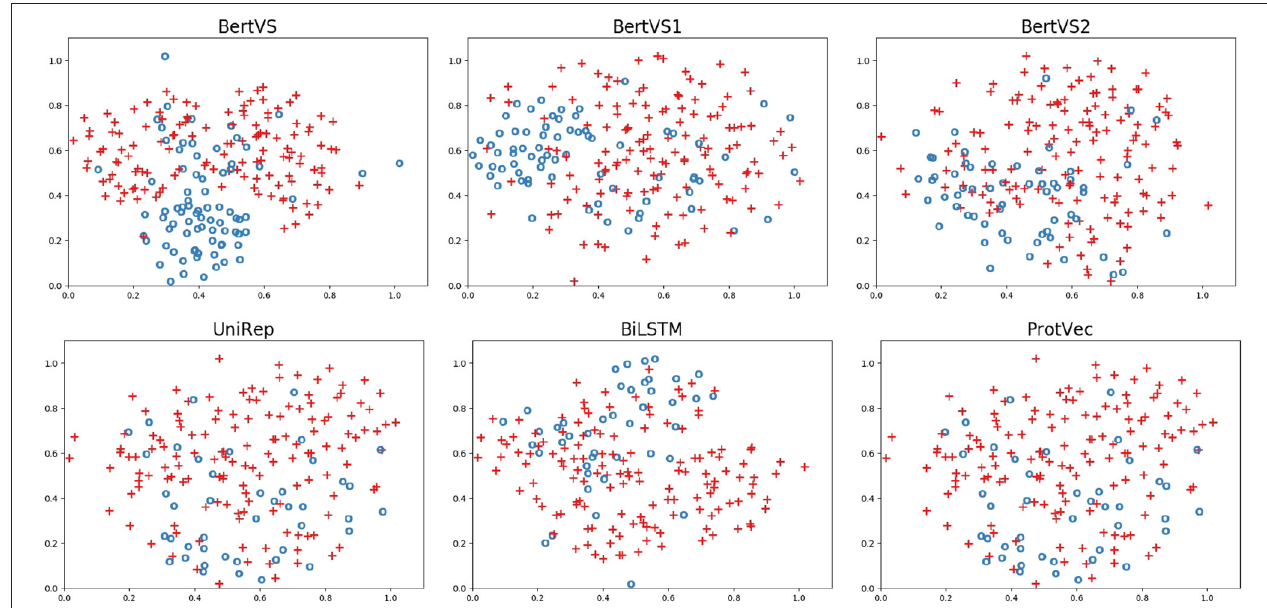
FIGURE 3 | The two-dimensional representation of the protein mutation sequences learned by the t-SNE method. The red node represents a benign mutation, and the blue represents a pathogenic mutation.